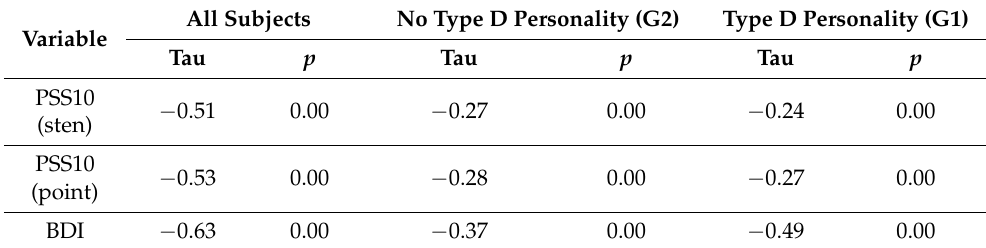
Table 2. Statistical analysis between the type of chronotype, the level of stress, and the occurrence of